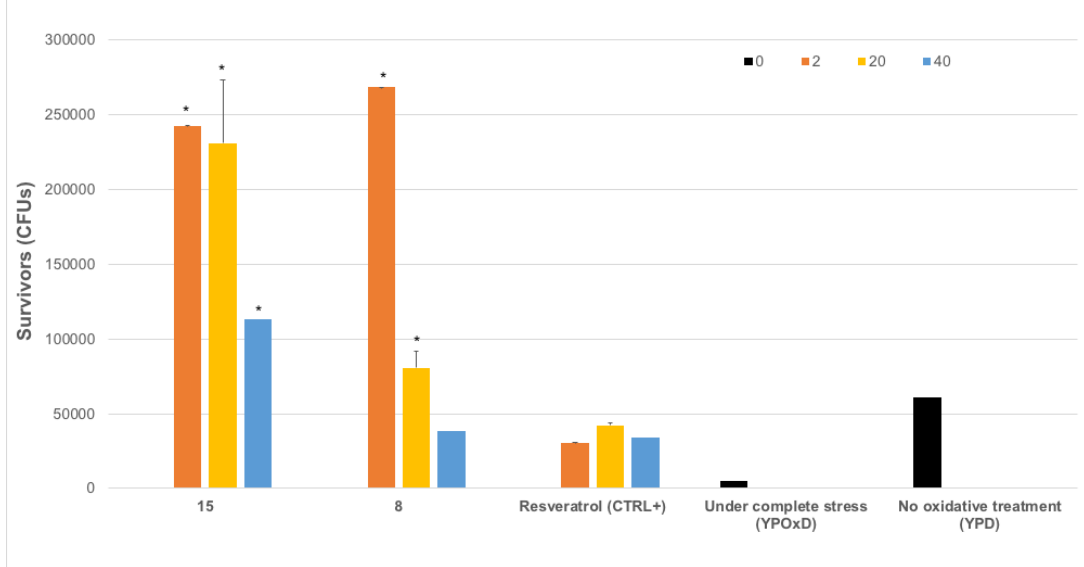
Figure 5. Saccharomyces cerevisiae survivors (mean CFUs (colony forming units) ± SEM) to oxidative stress after treatment with compounds 15 and 8 . Yeast cells were subjected to oxidative stress by growing in YPOxD medium, after 16h, cells were subjected to treatment with different doses (2, 10, 20 or 40 μg, check color code in legend) in triplicate, and after 60 h of growth monitorization by OD600 measurement in Bioscreen c, cells were serially diluted in 10% glycerol and plated in YPD medium plates, to determine number of CFUs per ml. Stressed yeasts without antioxidant treatment (under complete stress (YPOxD)), non-stressed yeasts (no oxidative treatment (YPD)) and stressed yeasts treated with resveratrol (resveratrol (CTRL+) were also included. Statistical significance (F-test with p -value lower than 0.05) was assessed first between YPOxD and YPD yeast survivors; and then between YPOxD stressed and antioxidant-treated, followed by comparison between control antioxidant (Resveratrol) and tested compounds at each dose. Asterisk indicates statistically significant comparisons (alpha = 0.05).